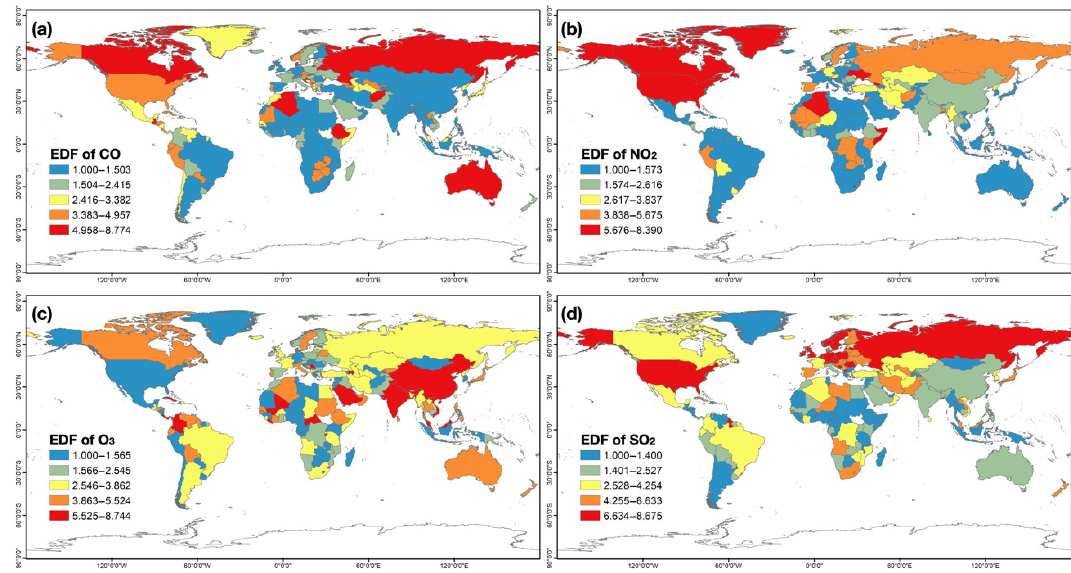
Figure 4. EDF of air pollutions estimated from GAM. ( a ) EDF of CO. ( b ) EDF of NO 2 . ( c ) EDF of O 3 . ( d ) EDF of SO 2 .